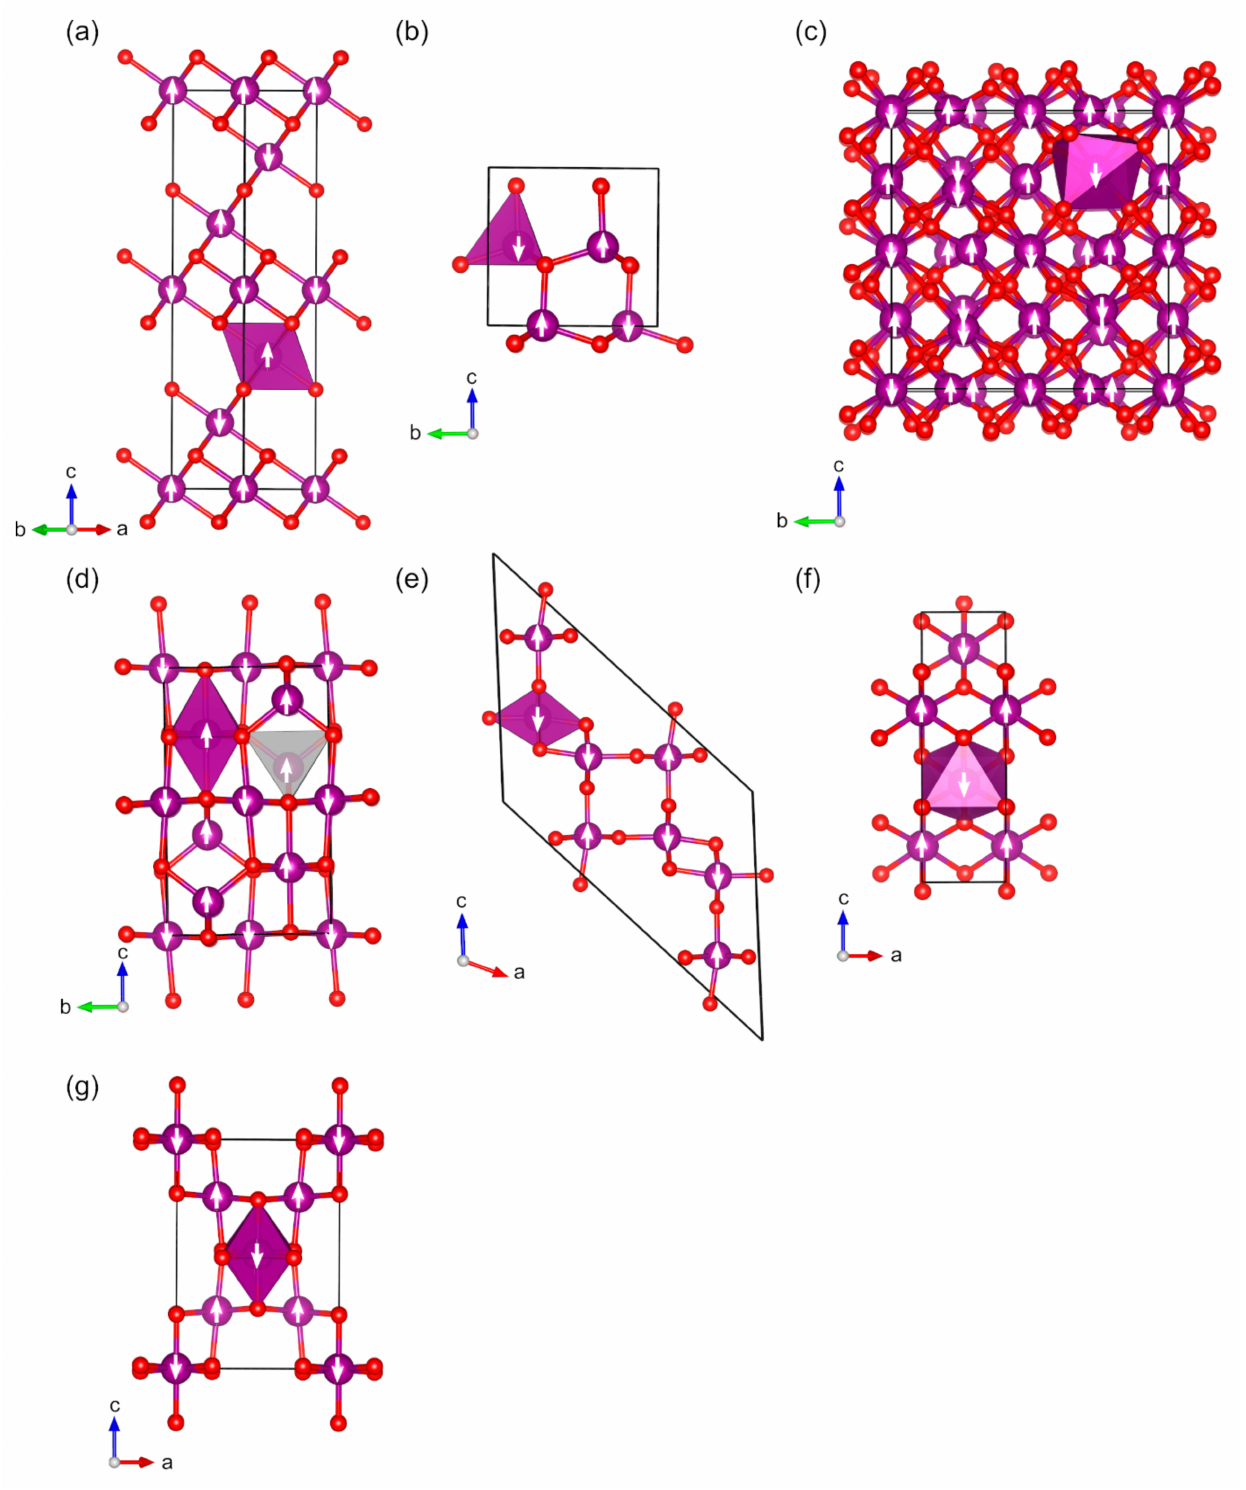
Figure 5. Optimized structures of studied magnetic binary manganese oxides red, O; violet: Mn: ( a ) MnO ( cF 8), ( b ) MnO (hP4), ( c ) Mn 2 O 3 ( oP 80), ( d ) Mn 3 O 4 ( tI 28), ( e ) MnO 2 ( tI 24), ( f ) MnO 2 ( oP 12), and ( g ) MnO 2 ( cF 48). The directions of magnetic moments are illustrated by white arrows. Coordination octahedra and tetrahedra of Mn atoms are shown in violet and light grey colors,